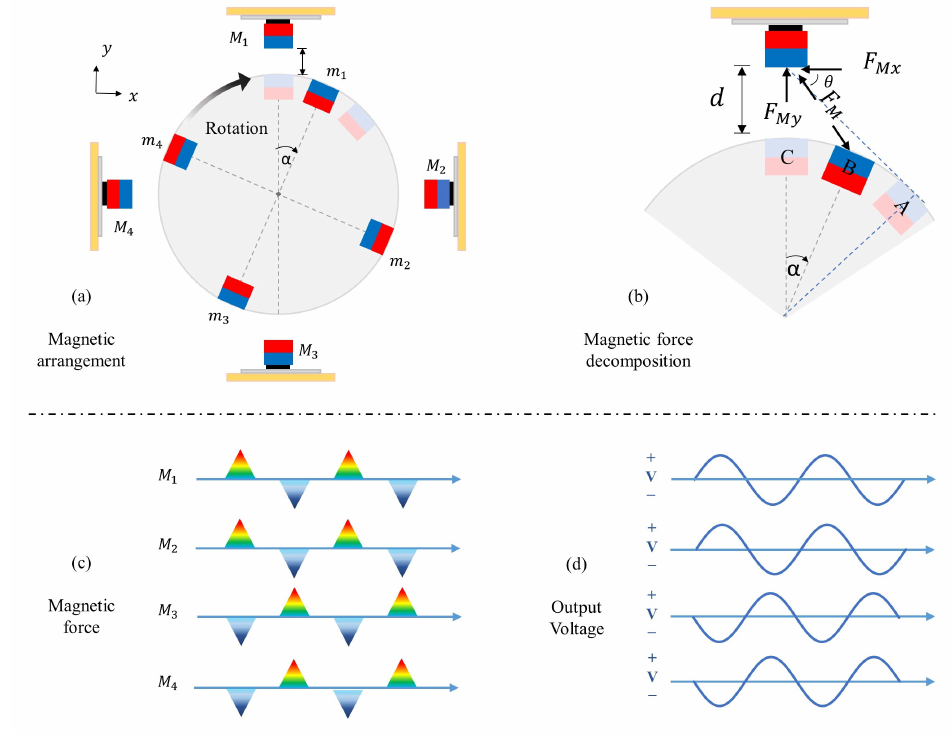
Figure 5. ( a ) The magnets that are arranged in a symmetrical opposite manner; ( b ) the magnetic force decomposition; ( c ) the magnetic force; and ( d ) the output voltage